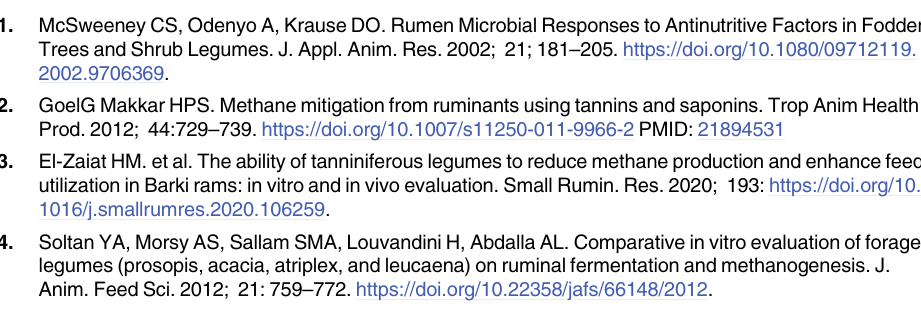
S1 Table. The relative abundance (%) of rare bacterial phyla and bacterial families and genera colonized to extracted and non-extracted atriplex, acacia, and leucaena at 6 and 12 hours incubations. S2 Table. Comparison of the relative abundances (%) of the main rumen bacteria in camels of current study and previous study and other ruminant